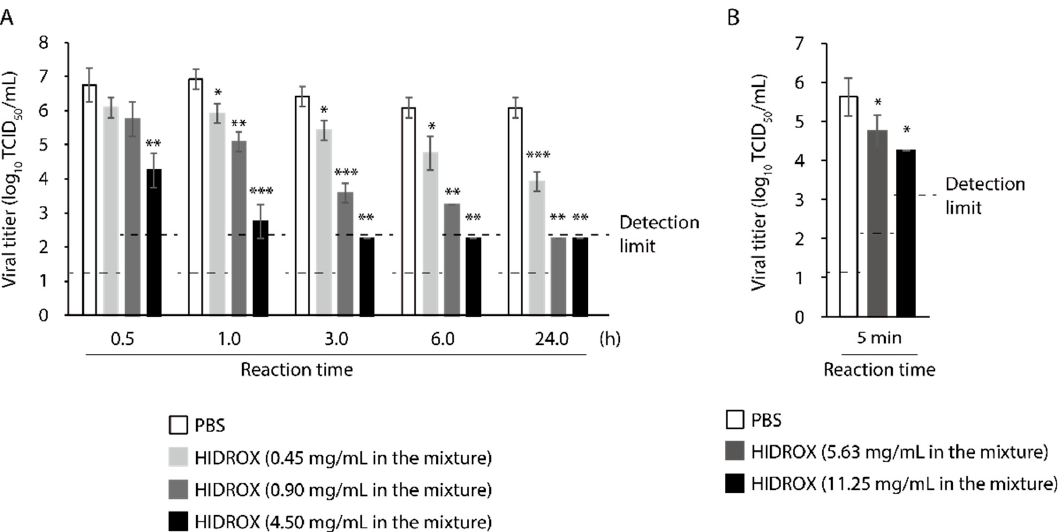
Figure 1. Time- and concentration-dependent virucidal activity of hydroxytyrosol (HT)-rich aqueous olive pulp extract (HIDROX) against severe acute respiratory syndrome coronavirus 2 (SARS-CoV-2). ( A , B ) SARS-CoV-2 was mixed with HIDROX. The final concentrations of HIDROX in the mixture were 0.45, 0.90, and 4.50 mg/mL ( A ) or 5.63 and 11.25 mg/mL ( B ). As a diluent control, PBS was mixed with the viral suspension. The mixtures were incubated at 25 °C for 0.5–24 h ( A ) or 5 min ( B ) and then the viral titers were evaluated. The detection limits of viral titer are 1.25 log 10 50% tissue culture infective dose (TCID 50 )/mL in the PBS and HIDROX (0.45 mg/mL) groups, 2.25 log 10 TCID 50 /mL in the HIDROX (0.9, 4.50, and 5.63 mg/mL) groups, and 3.25 log 10 TCID 50 /mL in the HIDROX (11.25 mg/mL) group. Results are indicated as mean ± SD ( n = 3–4 per group). Student’s t -test was performed to evaluate the statistically significant difference between the PBS and HIDROX groups; * p < 0.05; ** p < 0.01; *** p < 0.001.